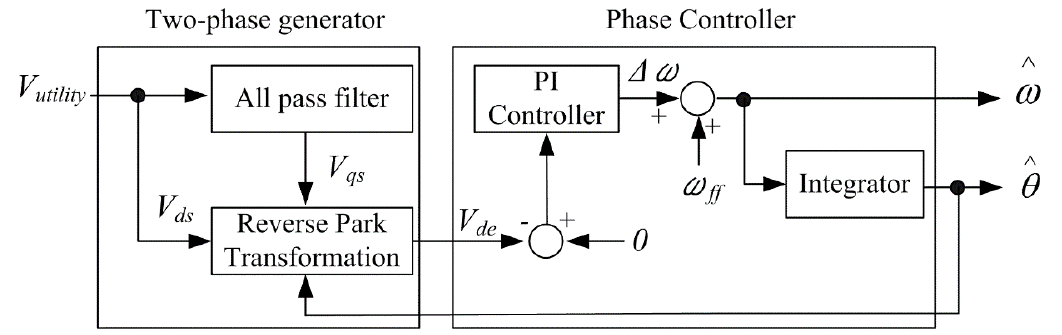
Figure 1. Block diagram of PLL for a single-phase PV inverter controller.